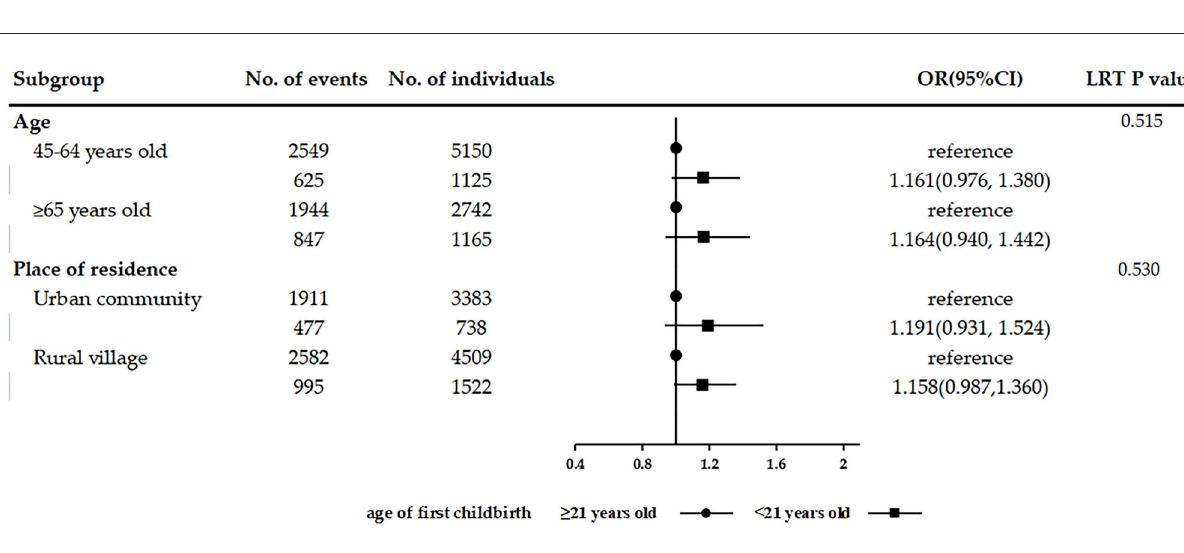
FIGURE3 Subgroup analyses on the association between age of first childbirth and multimorbidity stratified by age and place of